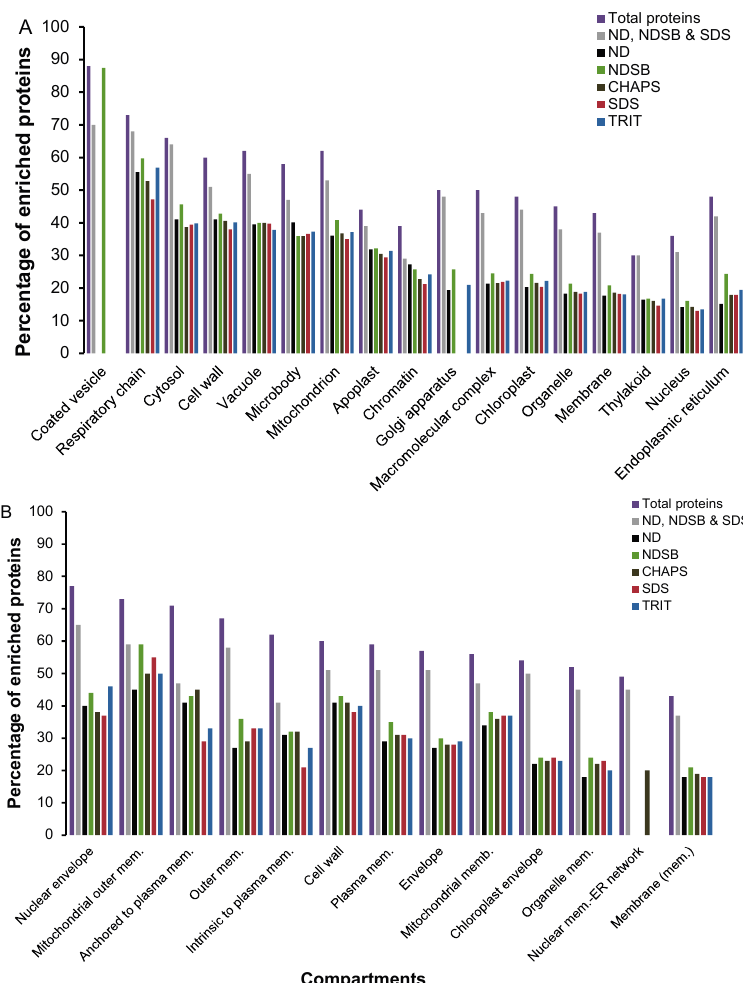
Figure 2. Enriched cellular compartments in ( A ) total unique and ( B ) membrane-associated proteins identified in the five buffer systems. Gene ontology (GO) analyses were performed using the entire dataset of identified proteins and then using the buffer-specific datasets separately. Cellular compartments that were detected as enriched are shown in the graph ( p ≤ 0.05 and false discovery rate (FDR) ≤ 1%). Bars represent the ratio of enrichment against the total number of proteins for each